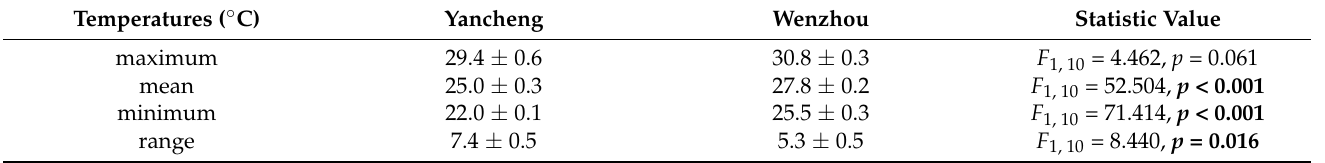
Table 1. Habitat (potential nest) temperatures of Gekko japonicus from Yancheng (northern population) and Wenzhou (southern population). Habitat temperatures of each location were recorded every three hours from early May to late July by ten iButtons (DS1921G, MAXIM Integrated Products, Ltd., San Jose, CA, USA) which were randomly placed in crevices of the buildings where gravid lizards were found. Data are expressed as means ± SE. p values in bold indicate significant